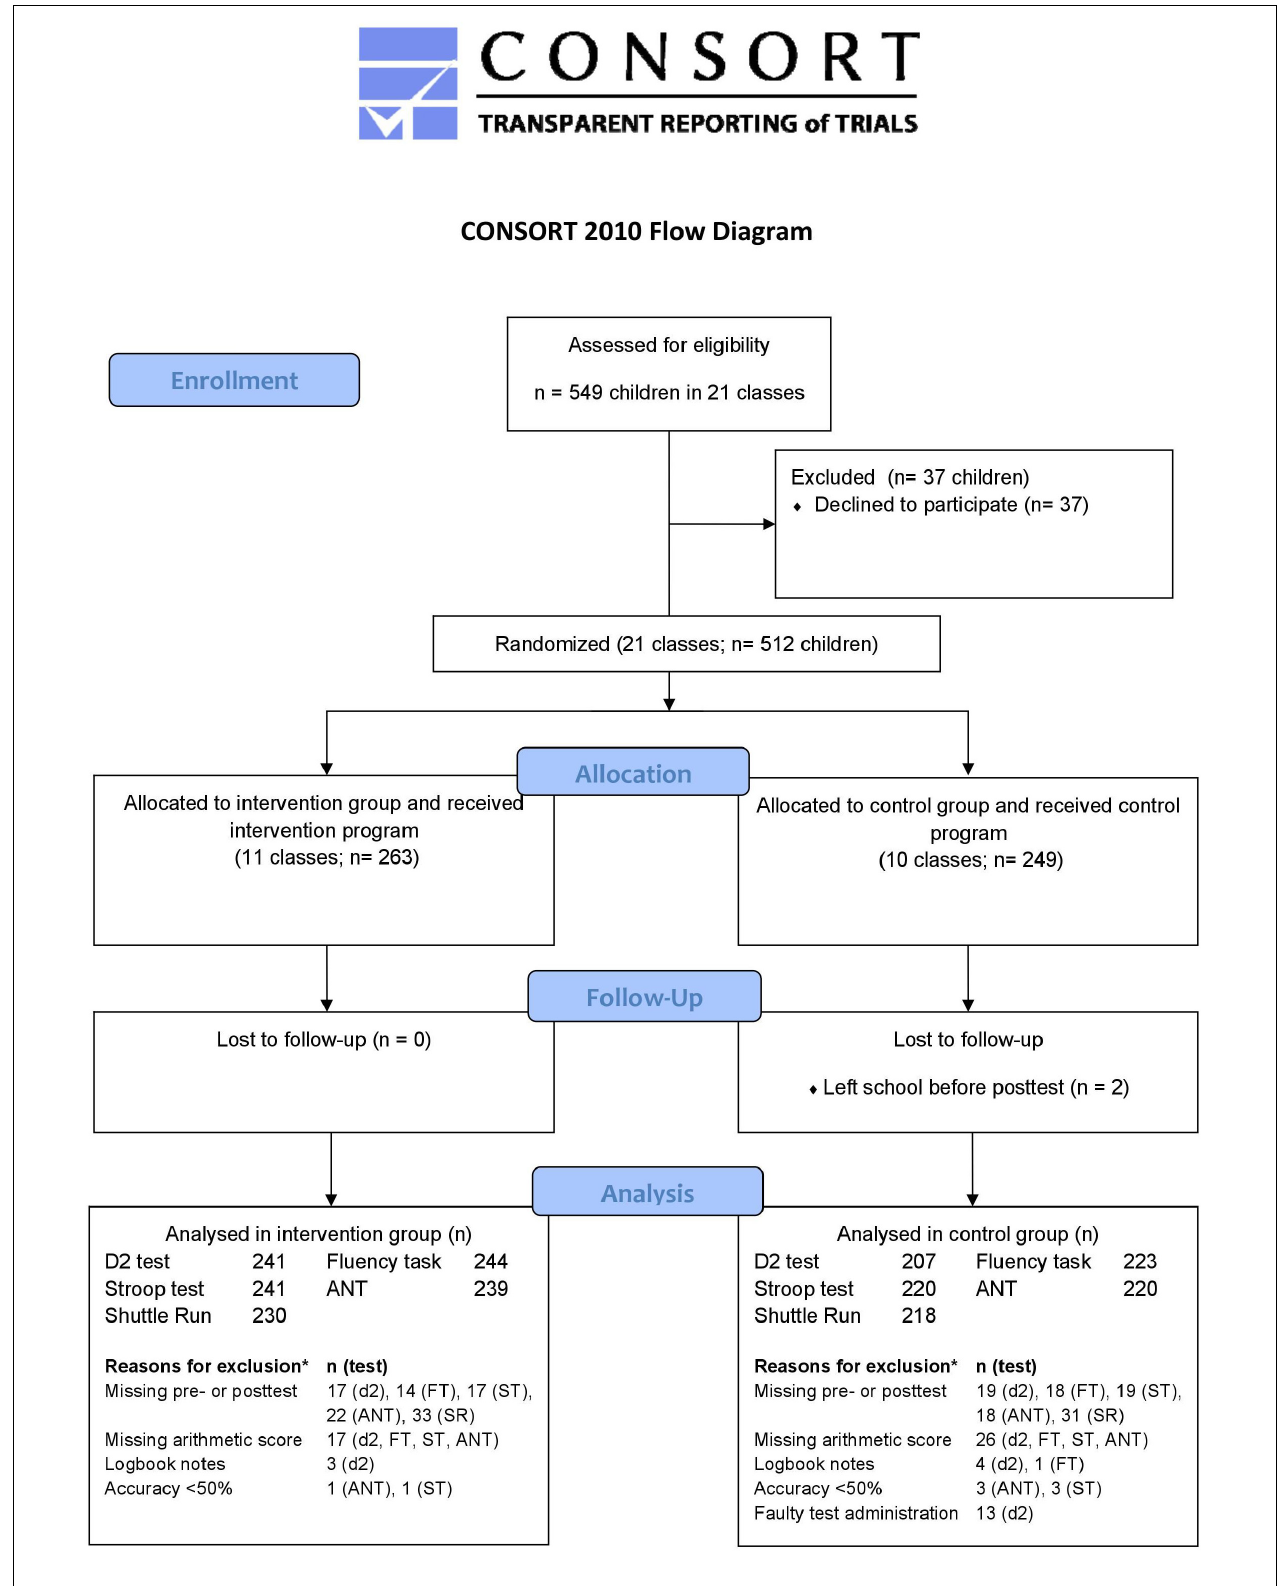
FIGURE 2 | CONSORT flow diagram: progress of participants through the trial. ∗ Children can be excluded for one or more reasons; e.g., a child with a missing arithmetic score can also have a missing pretest score. d2, d2 test; FT, Fluency task; ST, Stroop test; ANT, Attention Network Test; SR, Shuttle Run test.